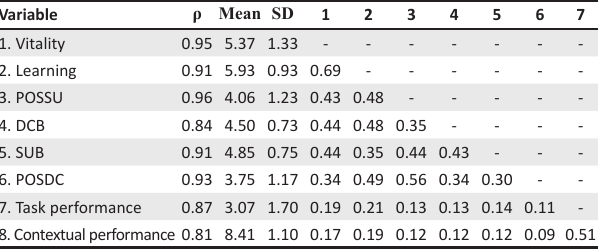
TABLE 2: Descriptive statistics, reliability coefficients and correlations of the scales ( n = 276).